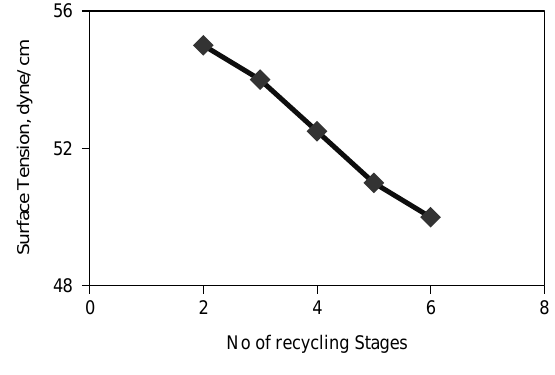
Fig. 5 Effect of recycled water on surface tension (0.5% H 2 O 2 , 0.1% NH 4 OH, 2.0 minutes pulping, 4.0 minutes flotation